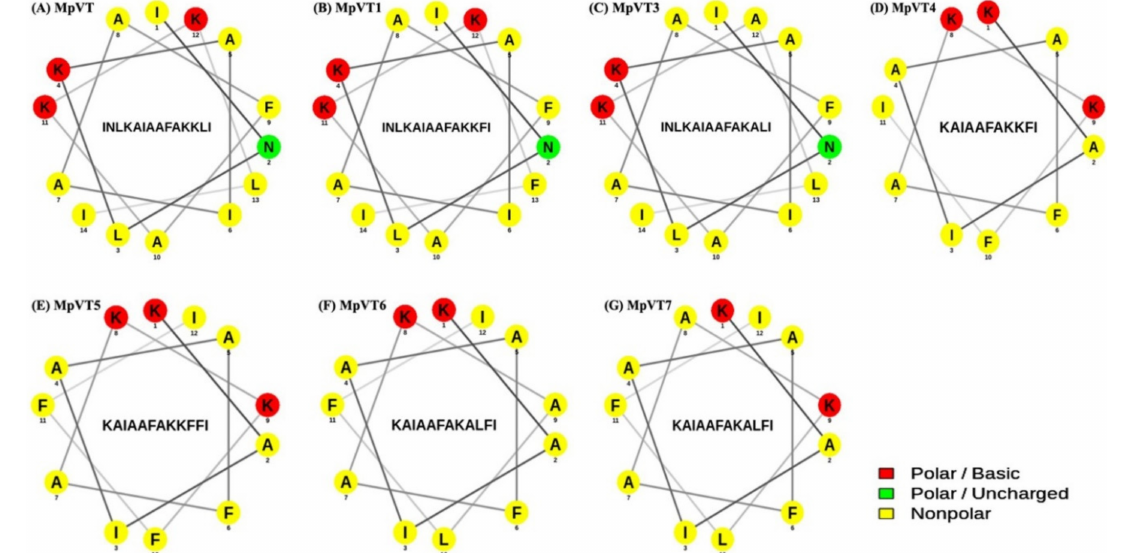
Figure 2. Helical wheel diagram of MpVT and its analogs ( A – G ). Helical wheel projection was performed using the Netwheels: Peptides Helical Wheel and Net projections maker. Red, green, and yellow circles represent polar/basic amino acids, polar/uncharged amino acids, and non-polar amino acids, respectively.